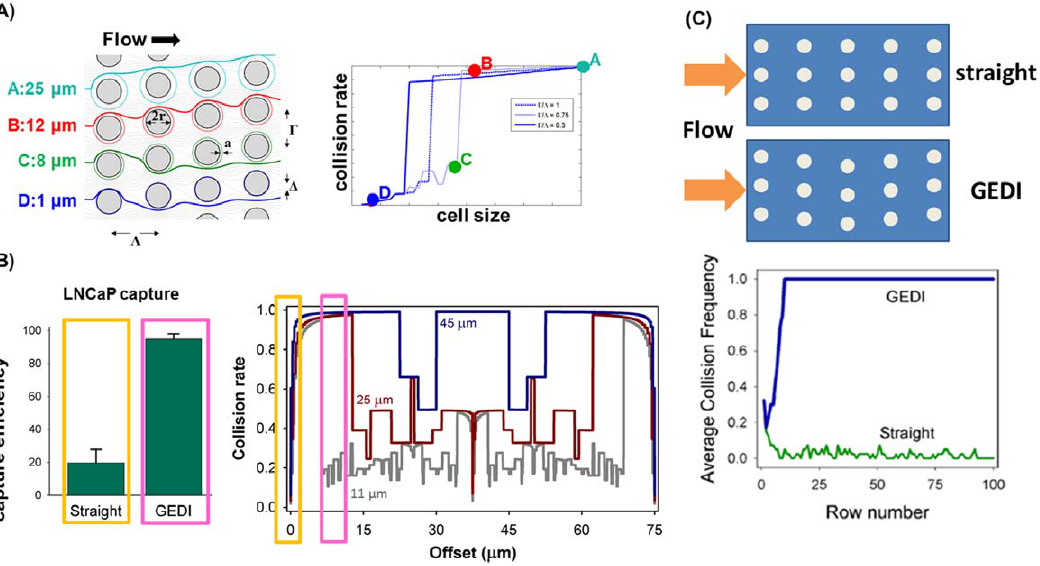
Figure 2. GEDI microfluidic device-results in cell lines recapitulate simulations. (A) Left: Top view of microfluidic obstacle array with array geometric parameters. D =obstacle offset. L =obstacle spacing in the direction of bulk flow. C =obstacle spacing in the direction orthogonal to bulk flow. 2 r =obstacle diameter. Streamlines (gray) denote fluid flow. Pathlines (various colors) denote trajectories of cells of different diameters. Obstacle array spacing and orientation parameters are also defined. Right: The rate of cell-wall collisions for cells traveling through the array is a strong function of the offset parameter of the array; the GEDI design methodology implies use of an offset parameter that leads to size-dependent collision rates. The results predicted for the flow through the geometry at left are shown at right by the solid line; the four specific cell sizes lead to results denoted by the four colored dots on this graph. Other geometric arrangements lead to different results, shown at right in the dotted and dashed lines. (B) Straight arrays or arrays with small offsets (gold boxes) lead to lower capture efficiency (left) and size independence (right). Carefully chosen offsets (magenta boxes) lead to high capture rates (left) and size dependence (right). Capture rates at left compare GEDI (7- m m offset) and straight (no offset) geometry performance as measured by LNCaP capture efficiency on J591-functionalized devices. Rates at right describe simulated collision rates in these geometries. Both experimental results have the same surface-area-to-volume ratio. (C) Devices with the same surface area to volume ratio give vastly different results: straight arrays lead to collisions that decrease as the blood travels through the device; GEDI arrays lead to collisions that increase with travel through the device.